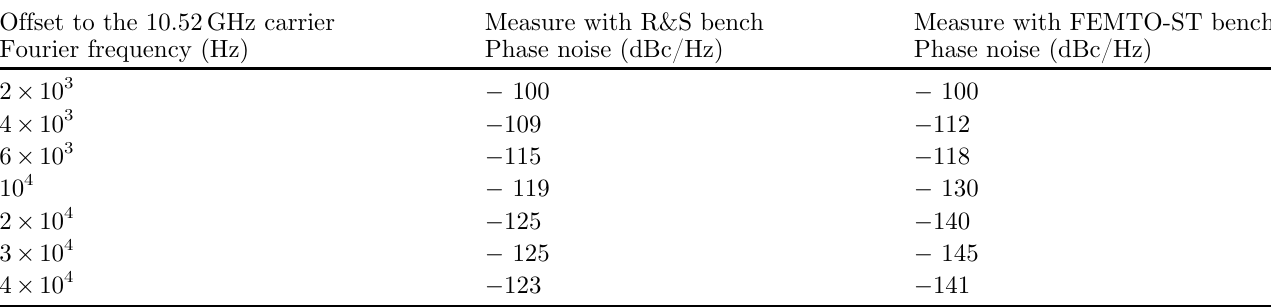
Table 1. Phase noise of an OEO with an output power of +5dBm at 10.52 GHz. Offset to the 10.52 GHz carrier Fourier frequency (Hz)